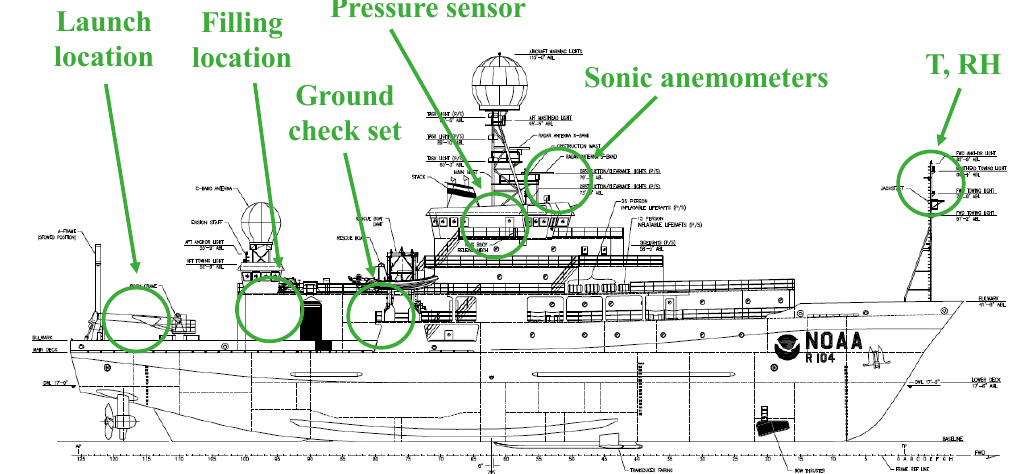
Figure 4. Schematic of NOAA Ship Ronald H. Brown annotated to show the location of key surface meteorological instruments as well as the staging bay where the balloons were filled and the approximate location of the fantail, where they were launched. Annotation colors from www.ColorBrewer.org by Cynthia A. Brewer, Geography, Pennsylvania State